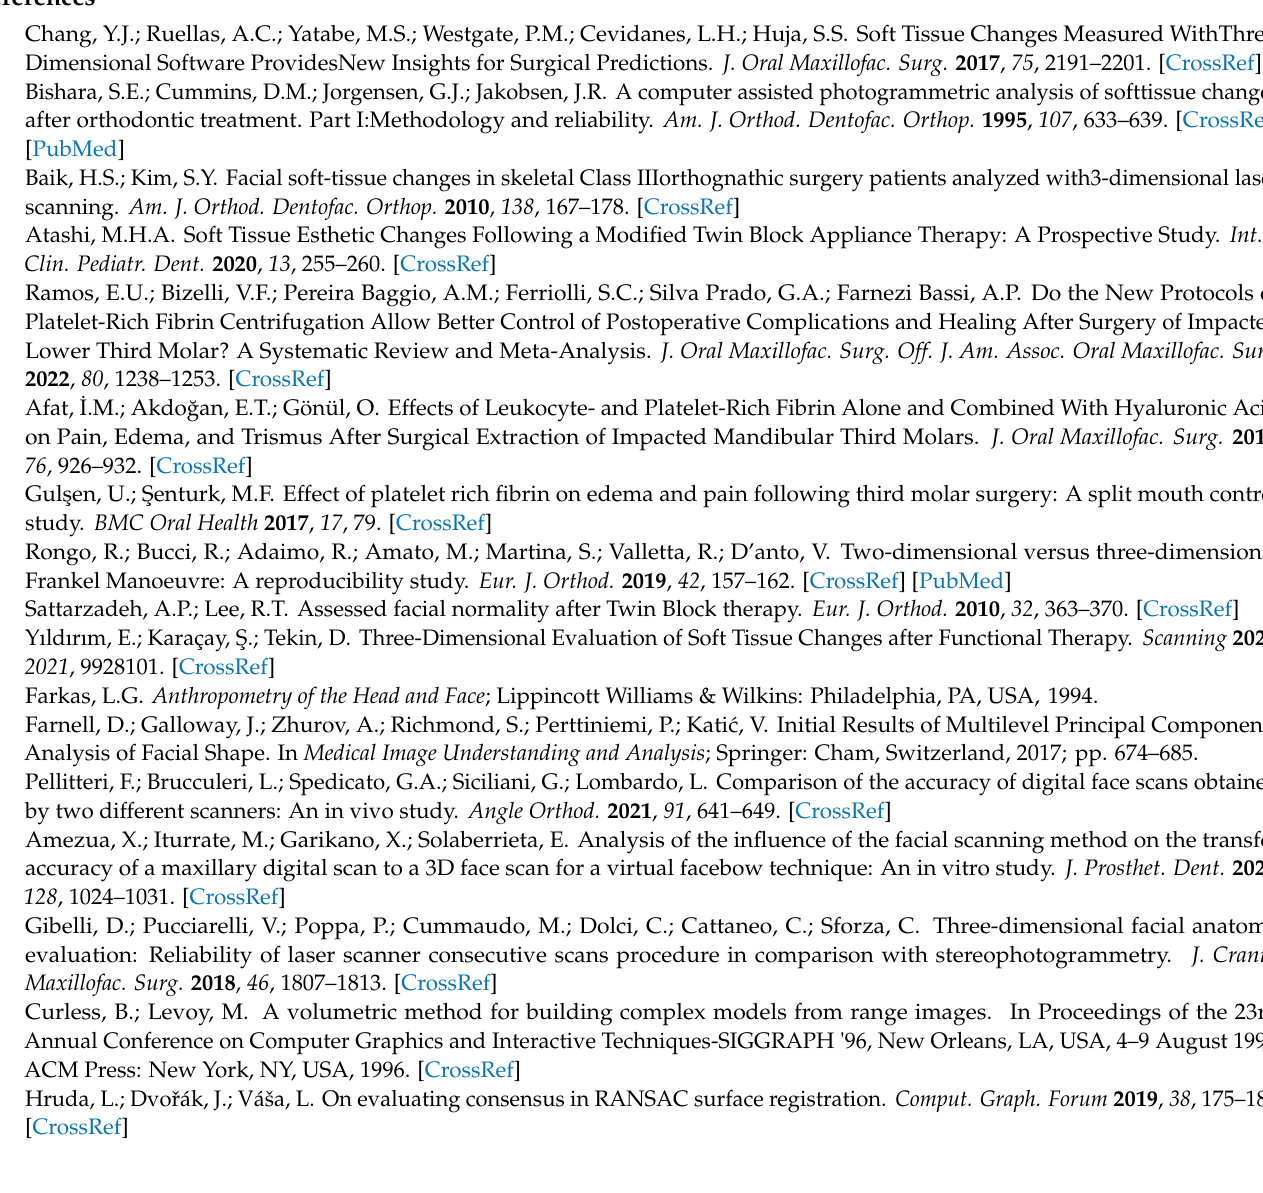
Figure A2. Different camera angles of measurement results ( a )—Right face view ( b ) —Left face